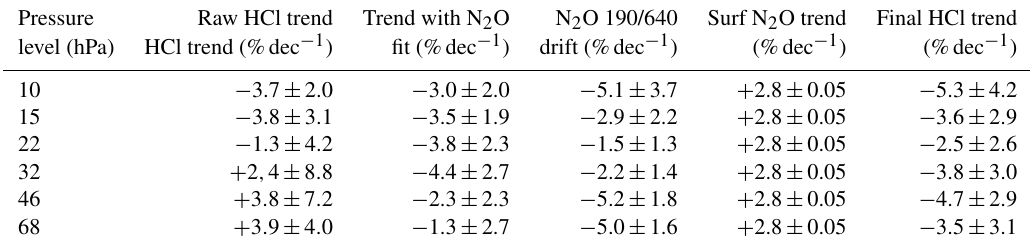
Table 1. HCl trends derived from MLS data at six pressure levels. Column 1 gives the pressure level. Column 2 gives the raw trend derived directly from the MLS HCl measurements in percent per decade. Column 3 gives the HCl trend derived using MLS N 2 O measurements as an explanatory variable. Column 4 gives the derived trend in the 190GHz channel of MLS N 2 O measurements relative to the 640GHz channel during the time of their overlap. Column 5 gives the slope of the NOAA global surface measurements of N 2 O over the period from 2001 to 2012. Column 6 gives the overall resulting trend obtained by combining the information in columns 3 to 5. All uncertainties are quoted at 2 σ